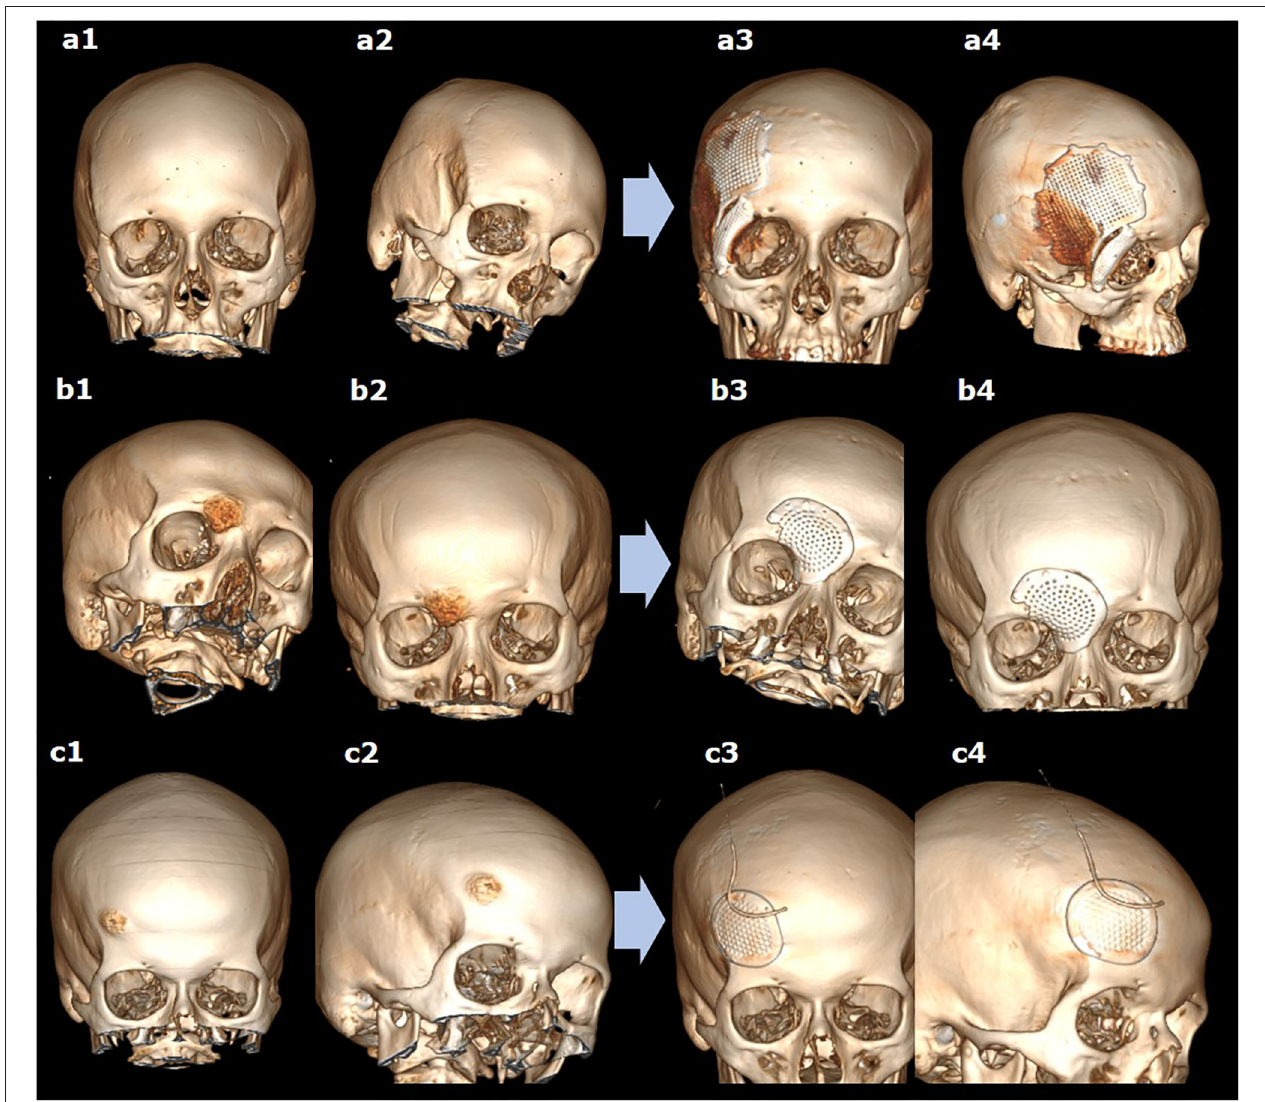
FIGURE 3 | The 3D reconstructions of CT scans before (a1–c1,a2–c2) and after (a3–c3,a4–c4) simultaneous resection of bone tumor and titanium cranioplasty in different cases of lesions in the fronto-orbital region, using two (a1–a4) or one (b1–b4,c1–c4)